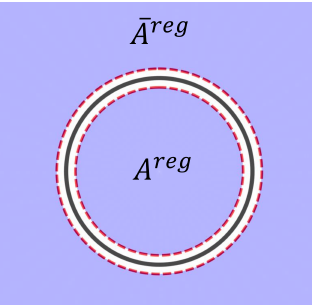
Figure 4: Here both of the region and the geometric regulator respect the rotation